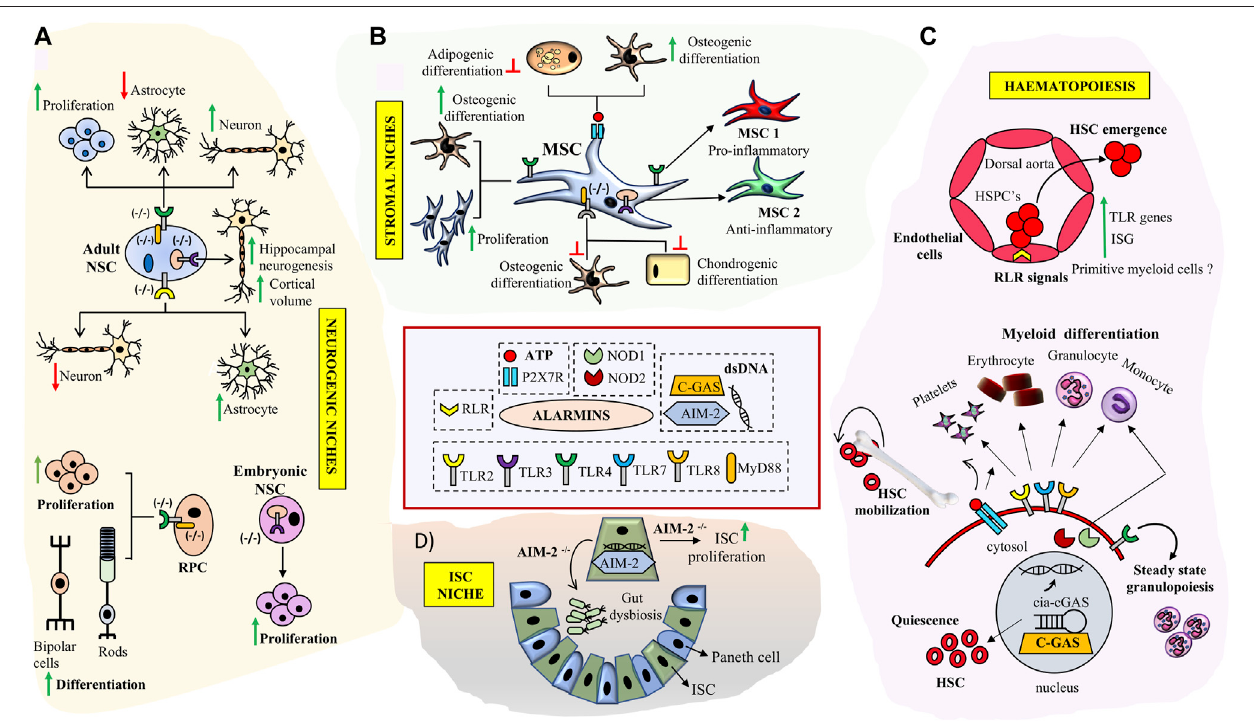
FIGURE 2| Role of keyAlarmin signals inneuronal, hematopoietic, intestinal and stromal tissue niches: (A) TLR signaling de fi ciency impacts NSC proliferation and neurogenesis in SVZ, DG and enhances RPC proliferation and differentiation in retina. (B) Triggering speci fi c TLR signaling pathways modulates immuno-plasticity and multi-lineage differentiation potential of MSCs and skews them into MSC1 (TLR4+) or MSC2 (TLR3+) phenotypes. Engagement of P2X7 receptor by ATP results in enhanced osteogenesis in MSCs (C) Broad roles of alarmin signals in HSC development and bone marrow niches. RLR signaling is implicated in HSC emergence through trans-differentiation of endothelial cell at HCCs during early development. TLR signaling and purinergic inputs impact HSC- quiescence, differentiation and mobilizationrespectively.InteractionofcGASwithcia-cGASpreventsHSCexhaustion.TLRsignalinginputsareimplicatedinmyeloidcelltypedifferentiation. (D) Double stranded DNA sensor AIM2 prevents gut dysbiosis and inhibits ISC proliferation in ISC